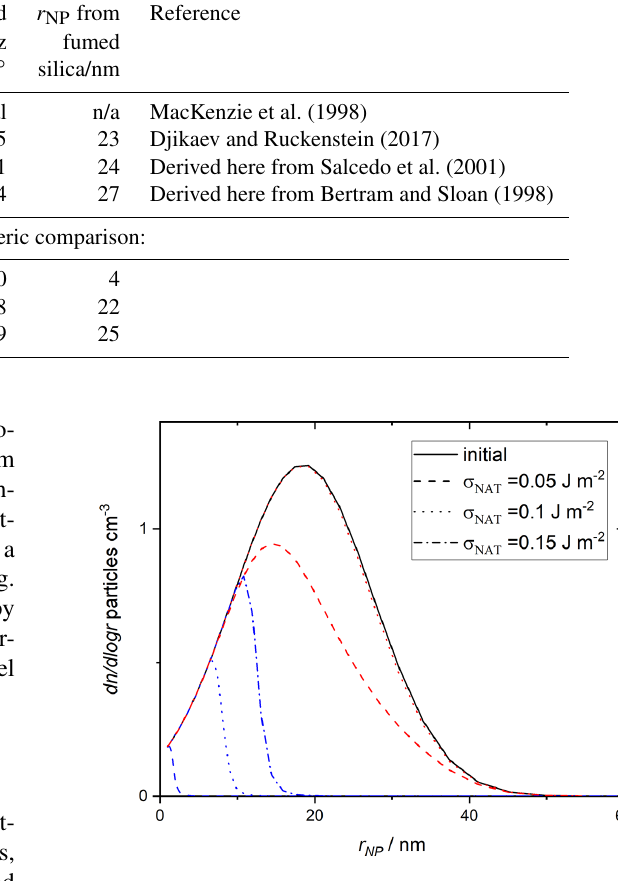
Figure 10. Size distribution of MSPs. Initial (solid black line) dis- tribution and that of the particles that “survive” (do not cause nu- cleation) is shown. Line style differentiates assumed surface energy values as indicated in the legend, blue lines show values assum- ing 15ppbv HNO 3 and red lines show values with 10ppbv. The surviving distribution assuming 10ppbvHNO 3 and σ NAT = 0 . 15 is indistinguishable from the initial distribution on this